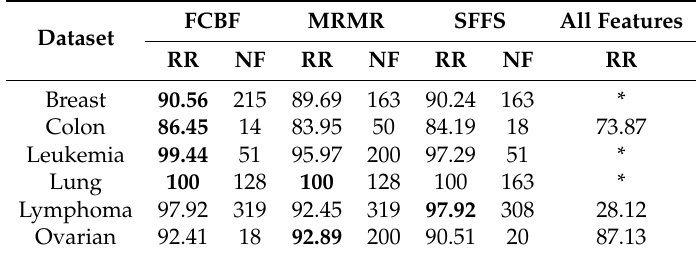
Table 9. Best results of heuristic search algorithms for feature selection with NN classifier.